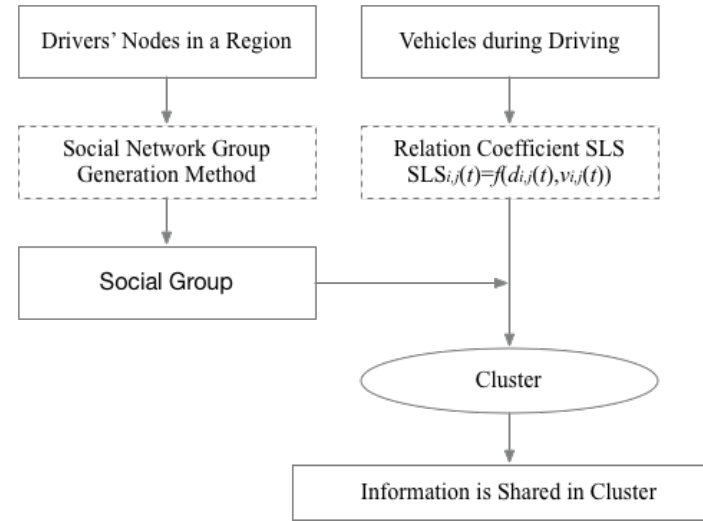
Figure 3. The flowchart of the